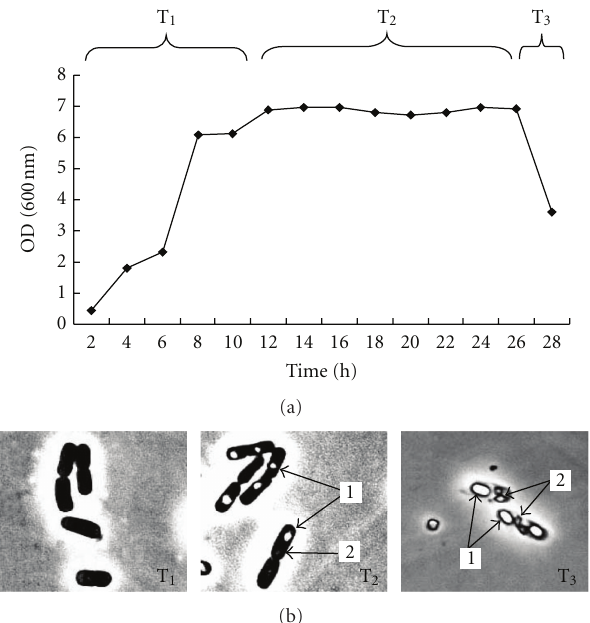
Figure 1: (a) Growth curve of Bacillus thuringiensis strain 4.0718. T 1 , middle vegetative phases T 2 , early sporulation phase T 3 , and late sporulation phase. (b) Morphology of Bacillus thuringiensis cells at di ff erent phases observed through phase contrast microscopy. 1: spores; 2: